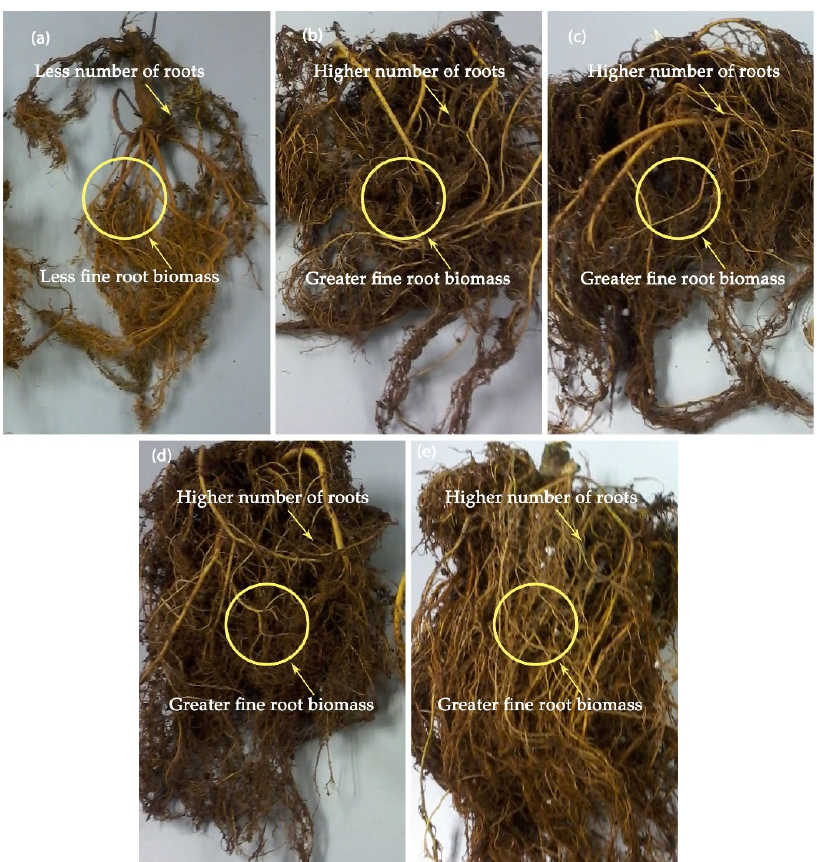
Figure 5. Effect of H 2 O 2 on root growth of F. deltoidea under polybagged condition after plant harvesting and processing. ( a ) 0 mM H 2 O 2 (control), ( b ) 15 mM H 2 O 2 , ( c ) 30 mM H 2 O 2 , ( d ) 60 mM H 2 O 2 , and ( e ) 90 mM H 2 O 2 . Photographs show the higher number of root and fine root biomass in all treated plants compared to the untreated control plants.